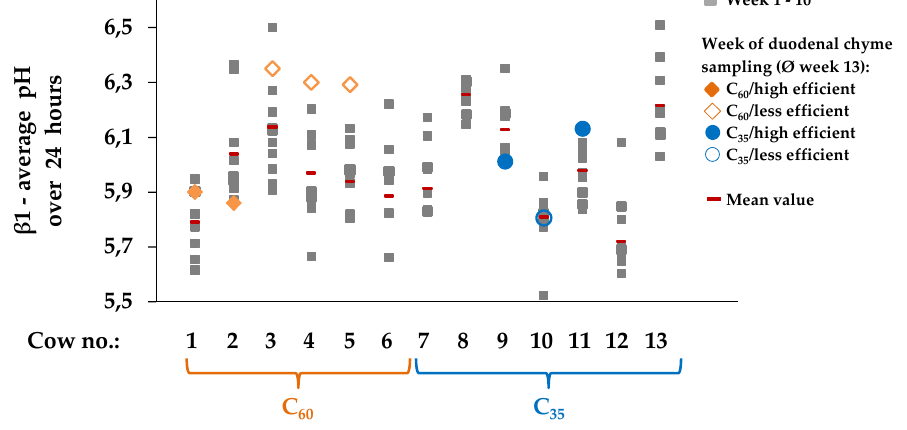
Figure 4. β 1 (describing the inflection point of the curve and representing the average pH of the 24 h period) for individual cows and each of the 10 experimental weeks as well as of the week of duodenal chyme sampling (on average week 13 p.p. ± 16 days)) reflecting the individual variability independent of grouping. After calving cows were assigned to a group with 60% concentrate feed proportion (increasing from 35 to 60% during the first three weeks after parturition, C 60 , orange , n = 6) and a group with 35% concentrate feed proportion ( C 35 , blue , n = 7) in the ration. For the week of duodenal chyme sampling, cows were additionally grouped into a more ( • / (cid:7) filled, 206 ± 17 g / kg, n = 5) and a less efficient ( ○ / ◊ , blank , 122 ± 17 g/kg, n=4) group in compliance with the average microbial efficiency of 156 g/kg defined as synthesized microbial crude protein/fermented organic matter according to GfE [15].